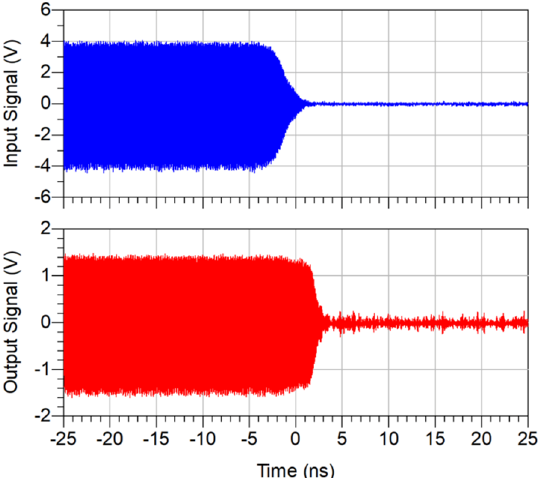
Figure 7. Input and output measured signals for the characterization of the Rx recovery time at 13 GHz.